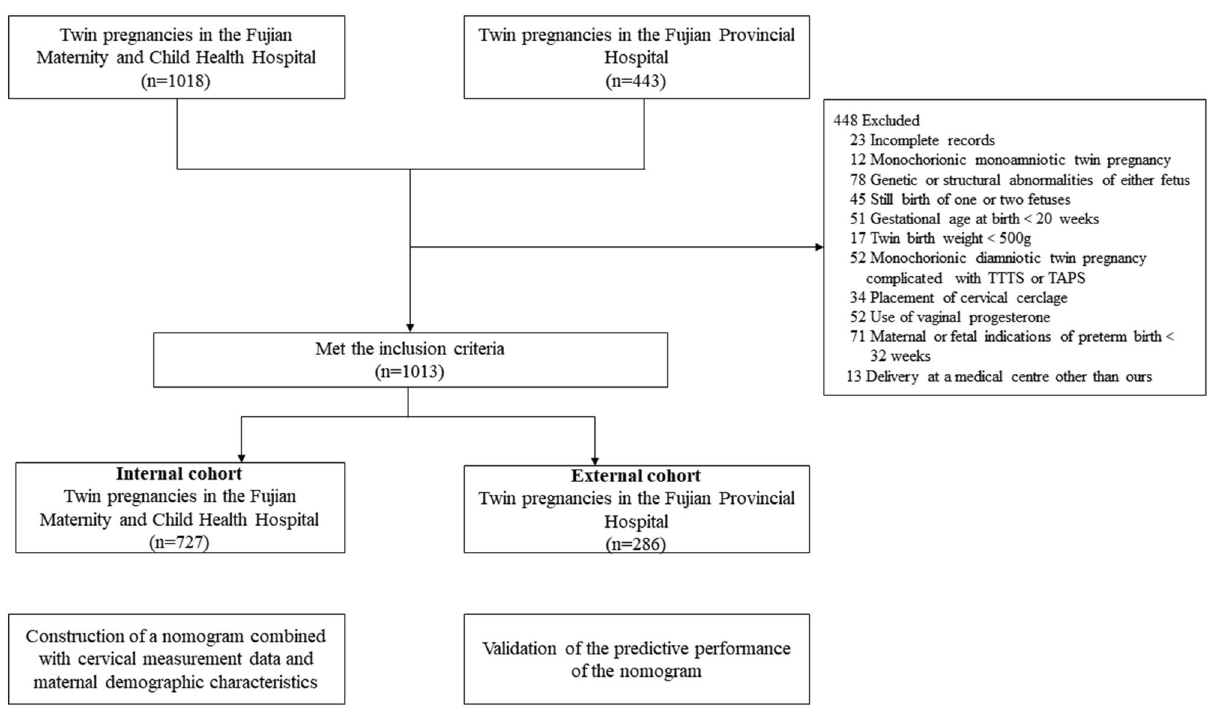
Figure 1. Selection process of